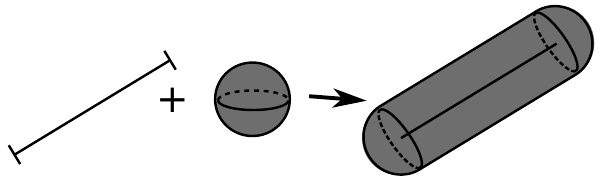
Figure 5. Oblong solid model as a Minkowski sum of a segment and a ball.